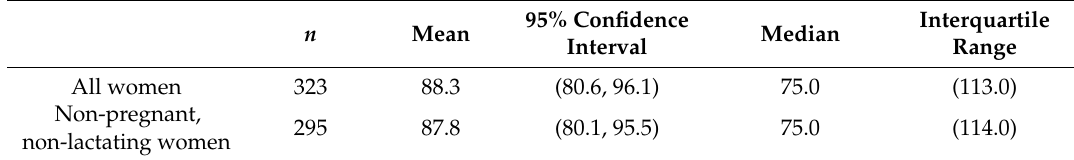
Table 2. Daily intake of iodine from supplements containing iodine among women of reproductive age (20–44 years): NHANES 2011–2014